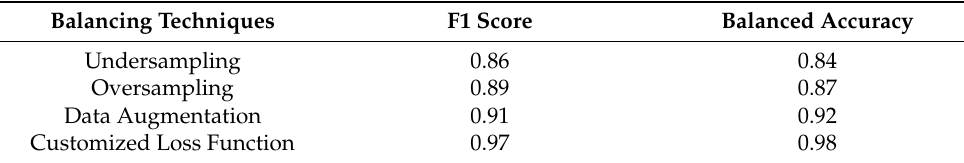
Table 2. Results for various balancing methods of the dataset samples.